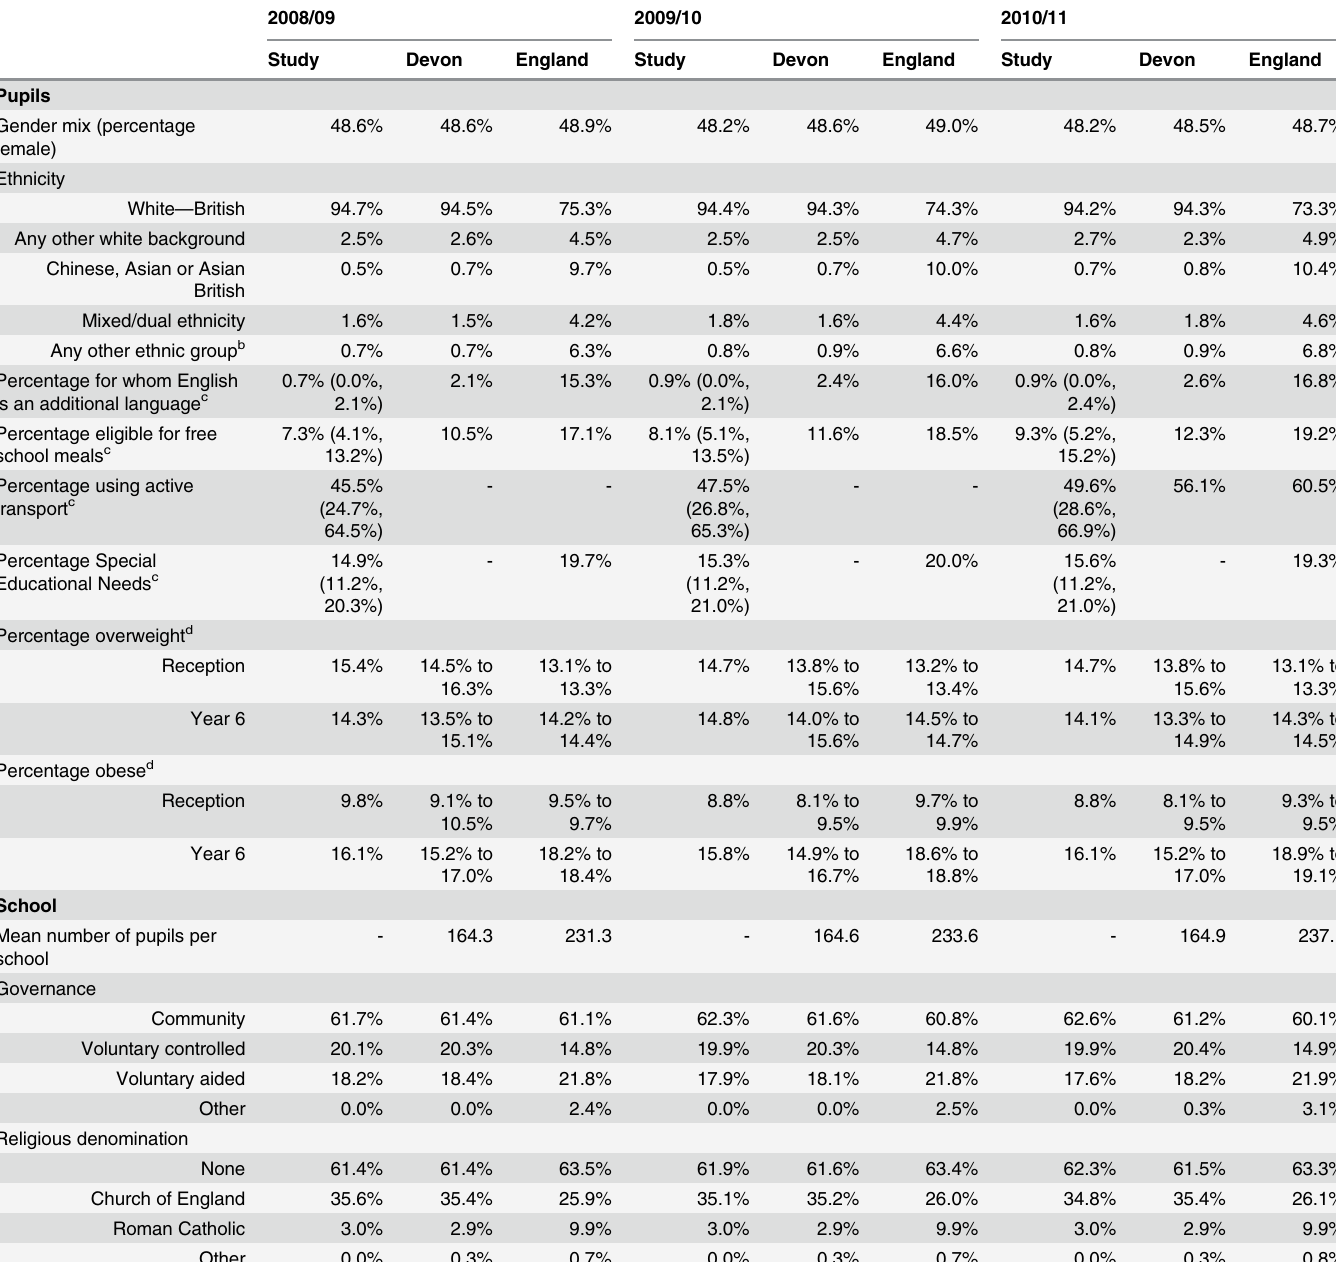
Table 1. Devon schools compared with national schools data 2008/09 to 2010/11 a